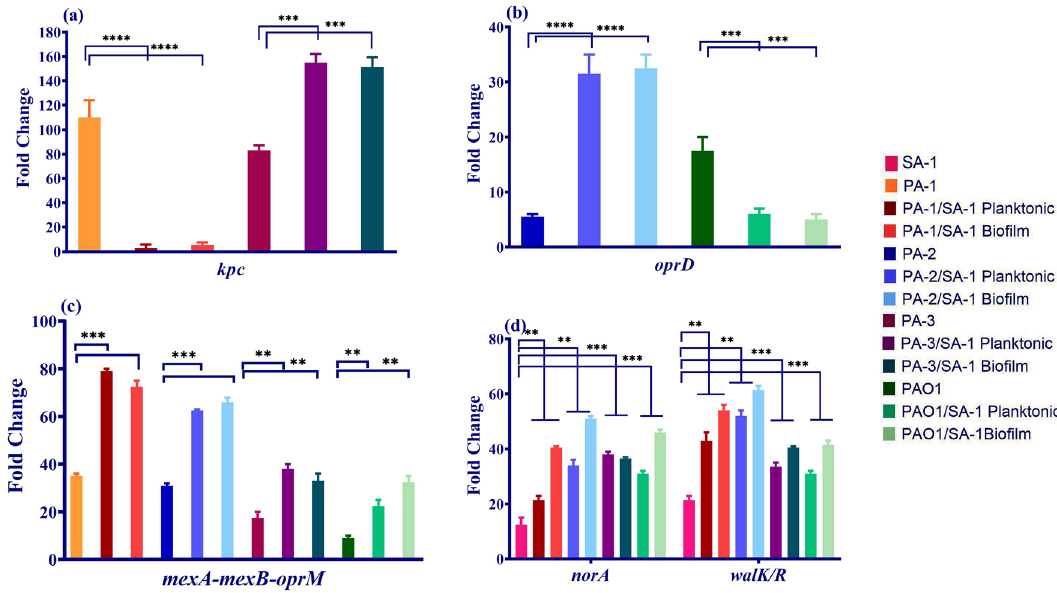
Figure 6. The expression level of resistance genes in P. aeruginosa and S. aureus in different states of co-culture. ( a ) The expression level of kpc in the planktonic and biofilm states of co-culture compared to the monoculture. ( b ) The expression level of oprD in the planktonic and biofilm states of co-culture compared to the monoculture ( c ) The mexA-mexB-oprM changes in P. aeruginosa strains in the planktonic and biofilm forms of the co- and monoculture. ( d ) The norA and walk/R changes in S. aureus strains in the planktonic and biofilm forms of the co- and monoculture. Each data set was analyzed using the student’s t-test, and the Holm-Sidak method for multiple comparison. The data were presented as Mean + SEM. * p-value < 0.05; **p-value < 0.01; ***p-value < 0.001; ****p-value < 0.0001.